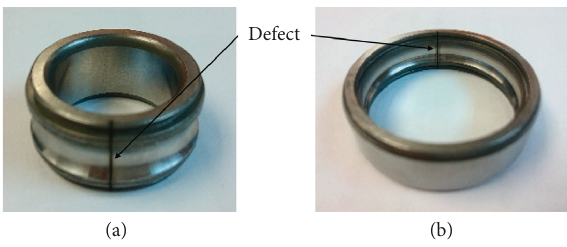
Figure 5: Bearing failure: (a) inner ring; (b) outer